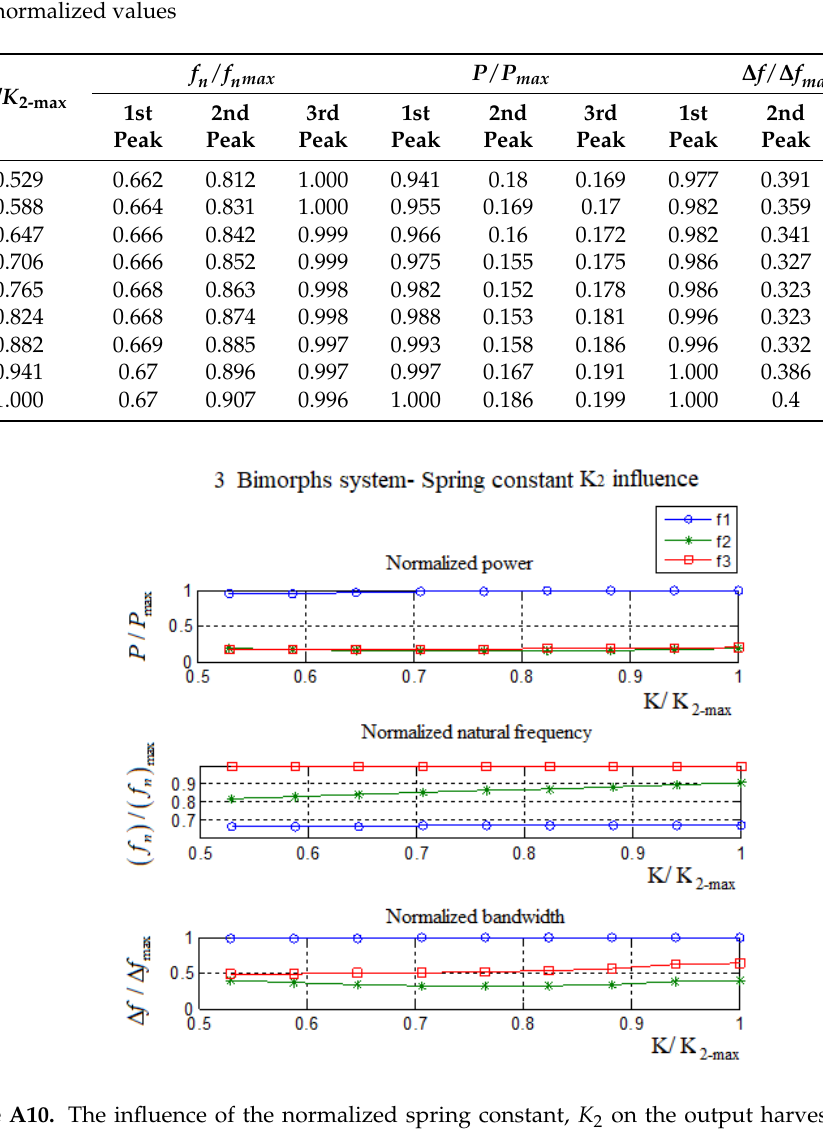
Figure A10. The influence of the normalized spring constant, K 2 on the output harvested power, natural frequency, and bandwidth (all normalized)—three bimorphs interconnected by two springs